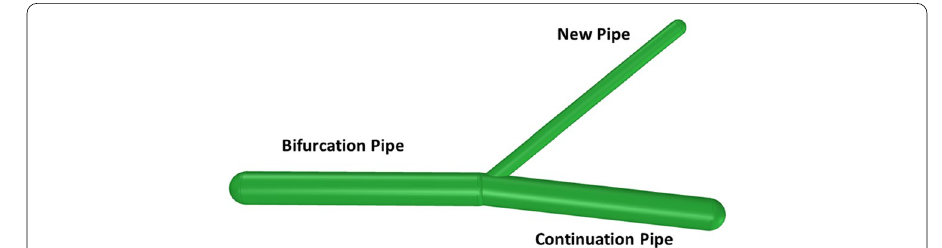
Fig. 2 Simplified representation of a bifurcation vessel with two daughters (new and continuation pipes) after the new pipe is permanently added to the virtual